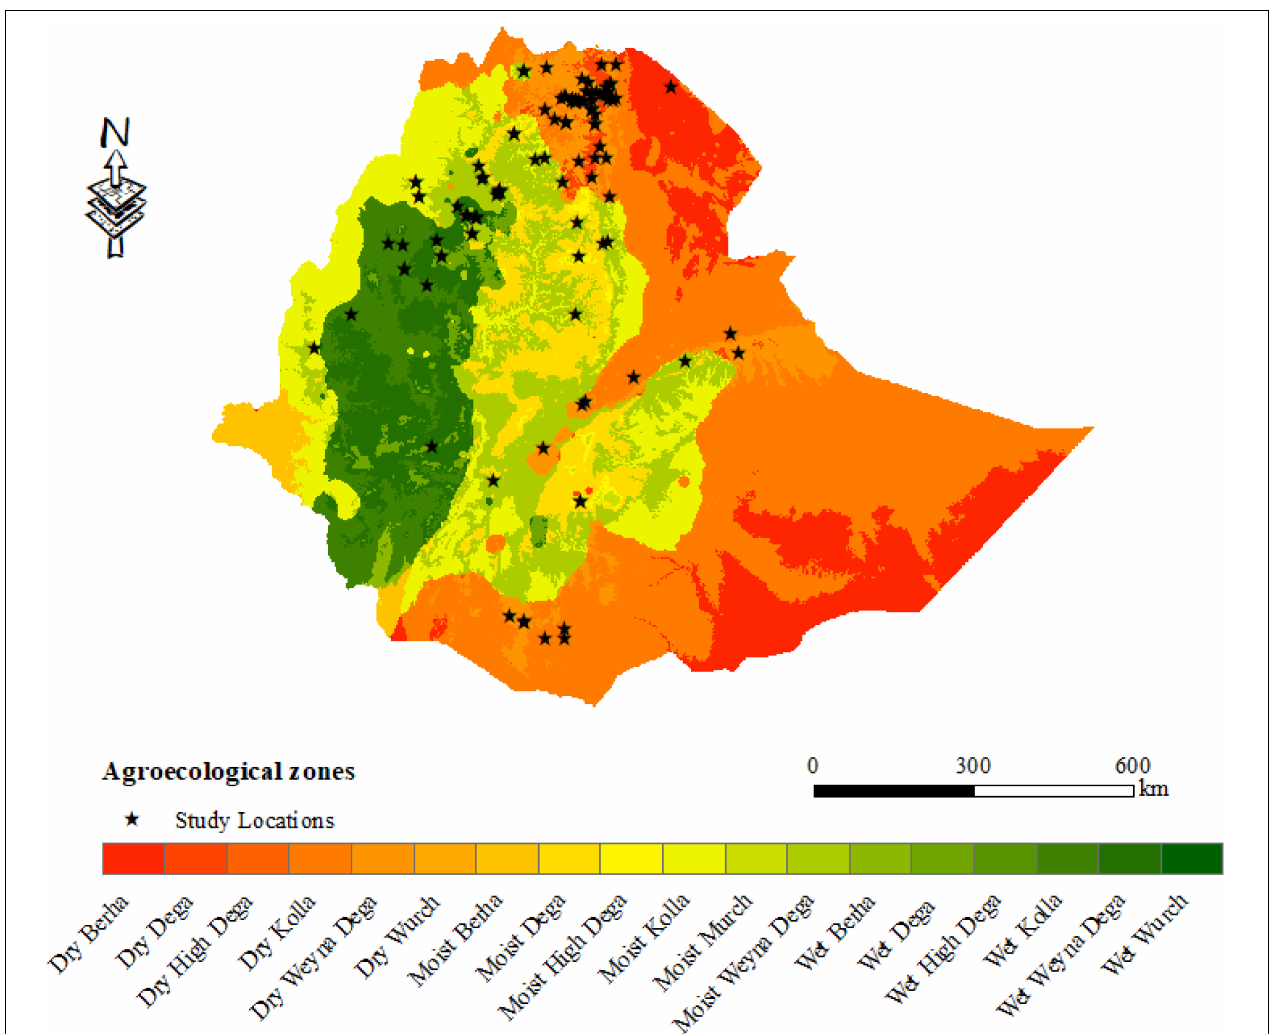
FIGURE 1 | Traditional agroecological classification of Ethiopia. See Table 2 for the characteristics of the agroecological zones.